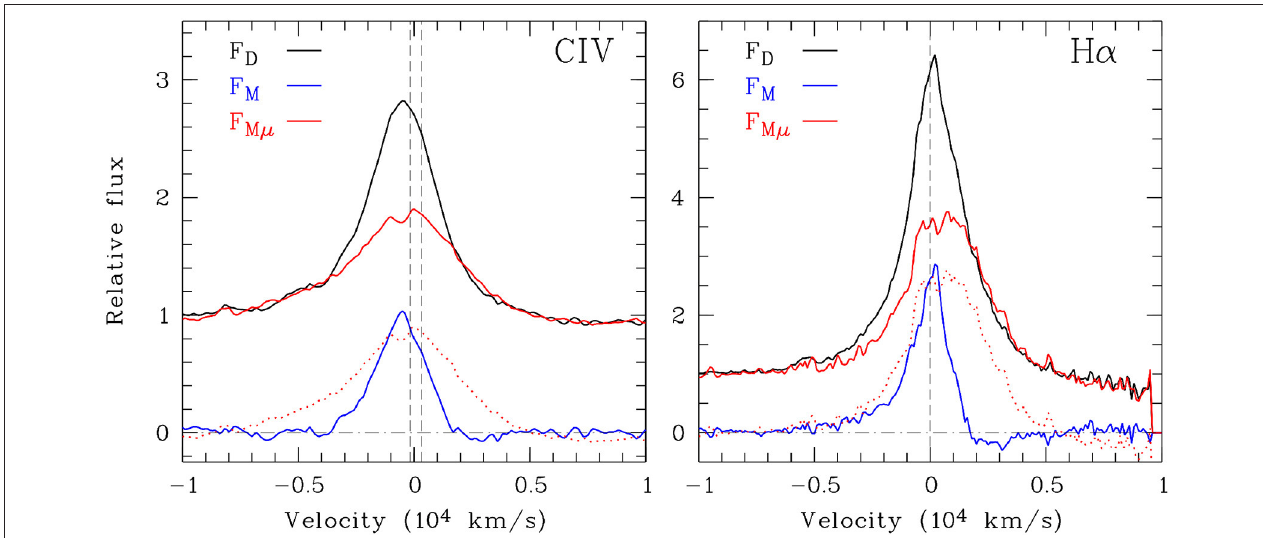
FIGURE 2 | Microlensing in the CIV and H α lines of the quasar Q2237 + 030. F D is the observed spectrum of image D which is not affected by microlensing. The line profile can be decomposed in a part affected by microlensing, F M µ , and another part not affected by microlensing, F M , with F D = F M + F M µ . The dotted line profile represents the continuum-subtracted F M µ